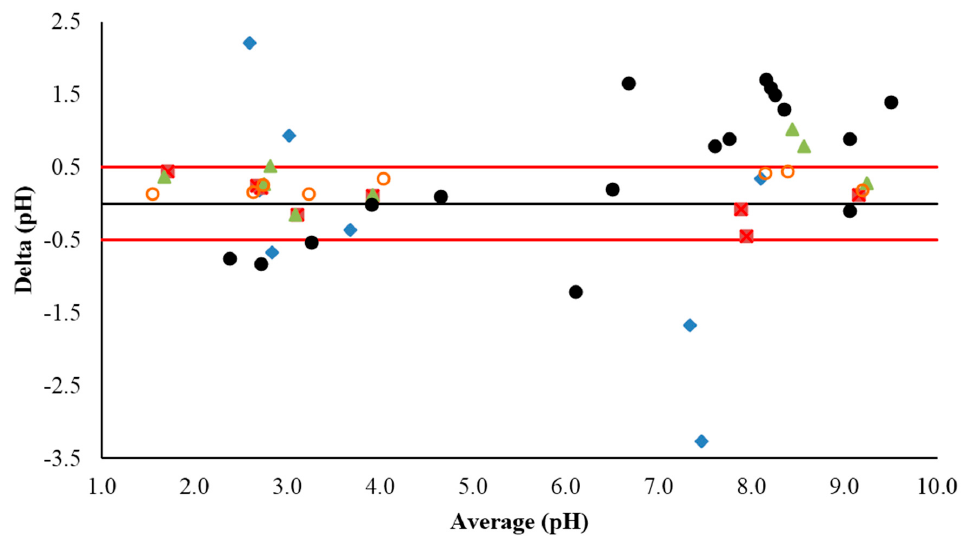
Figure 5. Bland-Altman plot for the pH sample data for RuO 2 pH sensors with RuO 2 -SiO 2 (Red Squares), RuO 2 -SiO 2 -KCl (Green Triangles), Glued-RuO 2 (Aqua Diamonds), and AgCl-KCl (Orange Circles) reference electrodes. Compared with sample data from the work by J. Noh et al. [25] (Black Dots). Red lines denote ±0.5 pH units from the “true” pH value.